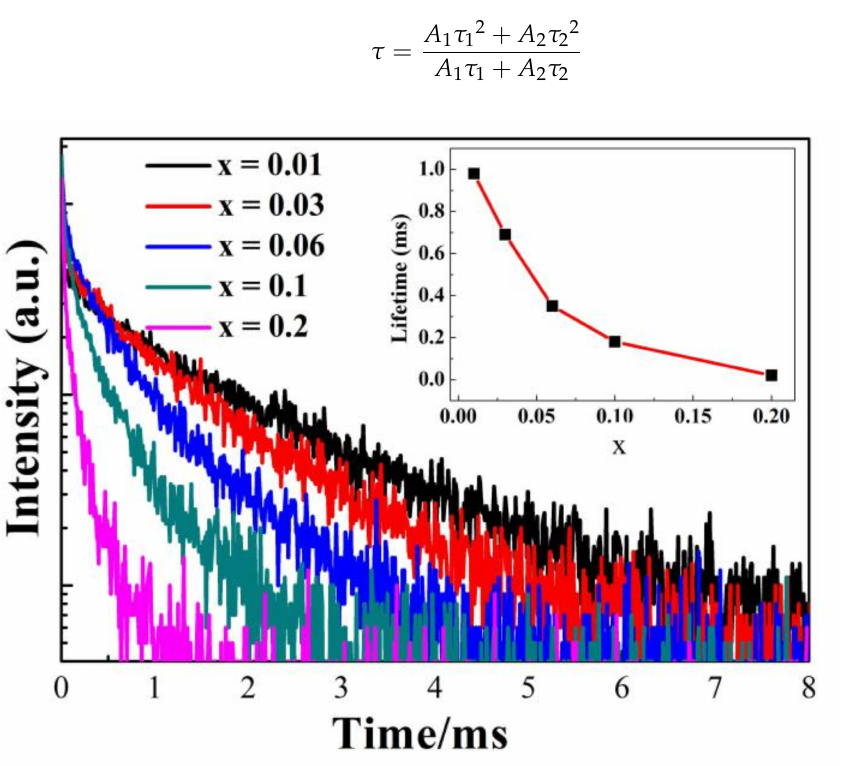
Figure 8. Decay curves and luminescence lifetimes of the 6 H 7/2 emitting level of Sm 3+ ions inAl 2 O 3 - (3-x)SrO: xSm 3+ (x = 0.01, 0.03, 0.06, 0.1, 0.2) glasses.